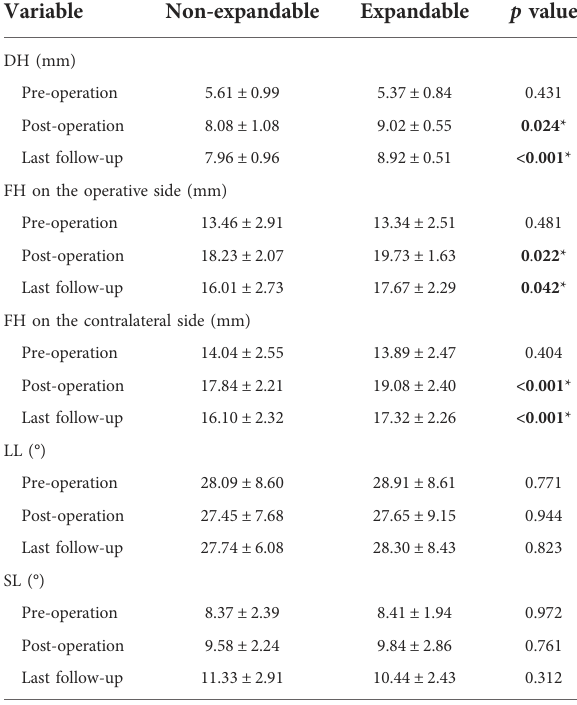
TABLE 4 Radiographic outcomes at pre-operation, post-operation and last follow-up between patients instrumented with EXP-IFC and